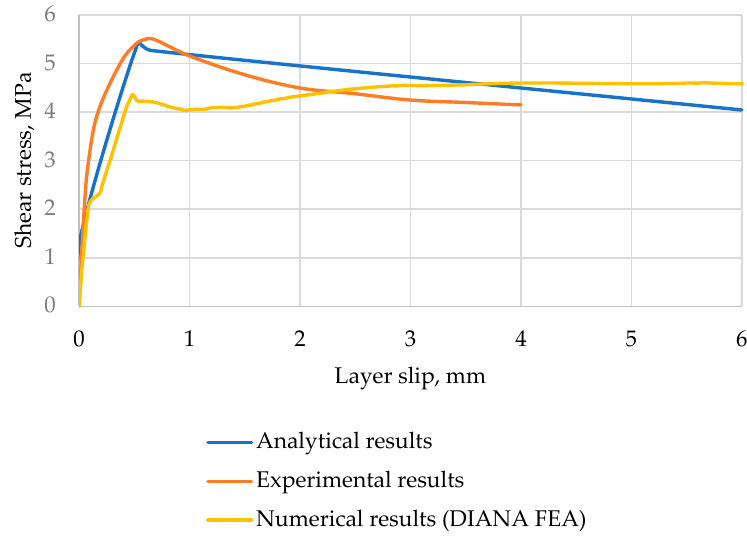
Figure 8. Shear stress–layer slip curves of specimen S-C65L30-6D8-Ba.